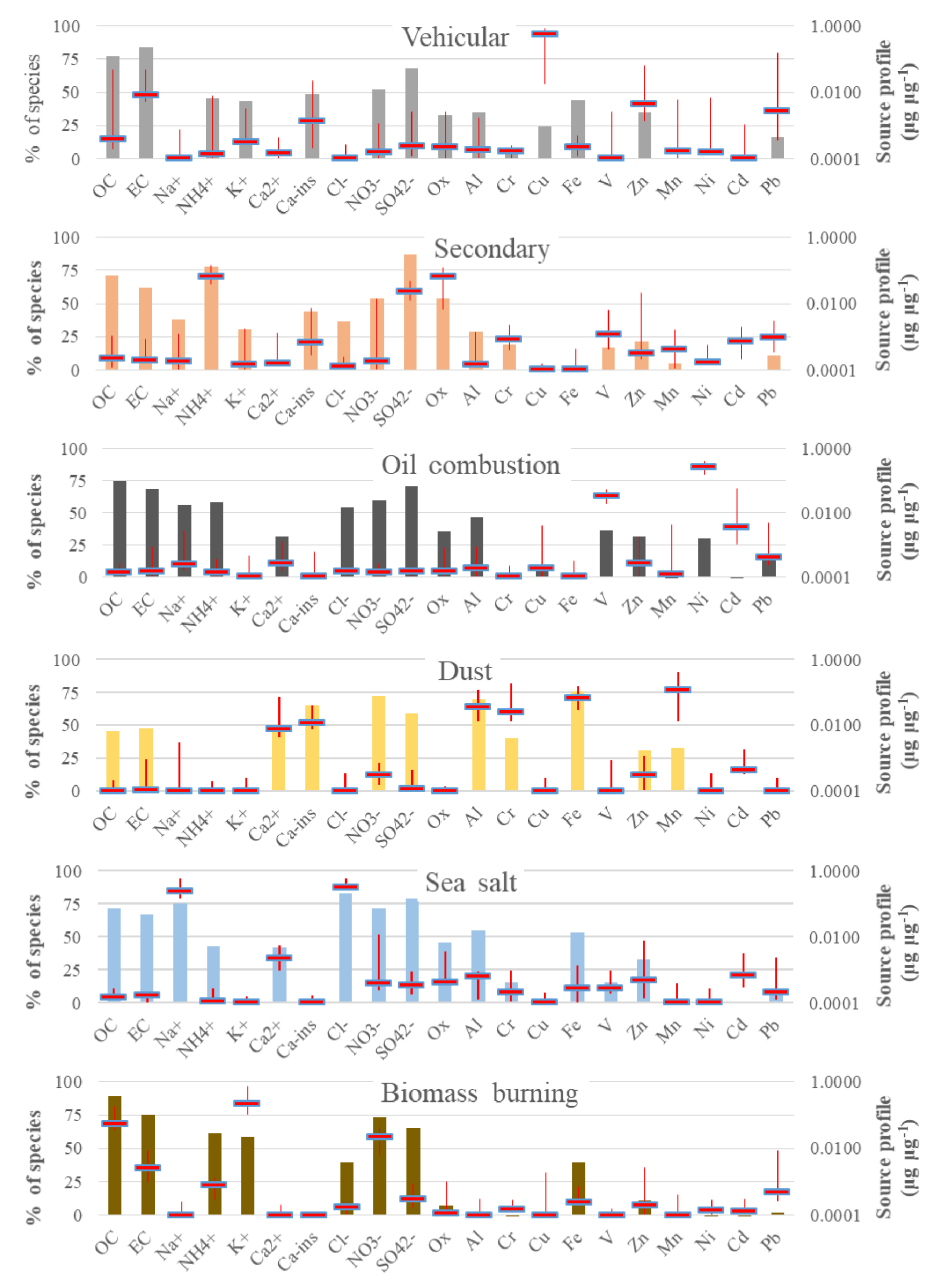
Figure 7. Average contributions to the component mass (%, red markers) and source profiles (µgmg − 1 , colored vertical bars) of PMF- resolved sources. Error bars provide the interquartile range from bootstrap